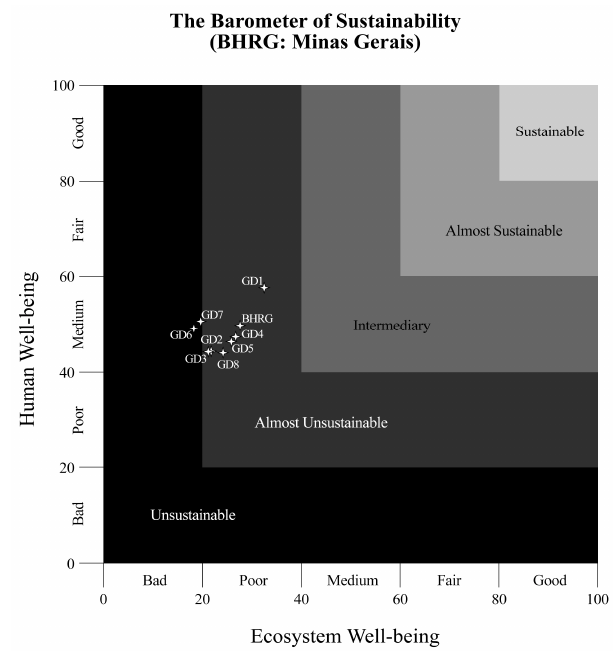
Figure 4. Two-dimensional graphs representing water sustainability condition at BHRG and its respective water management units in Minas Gerais.